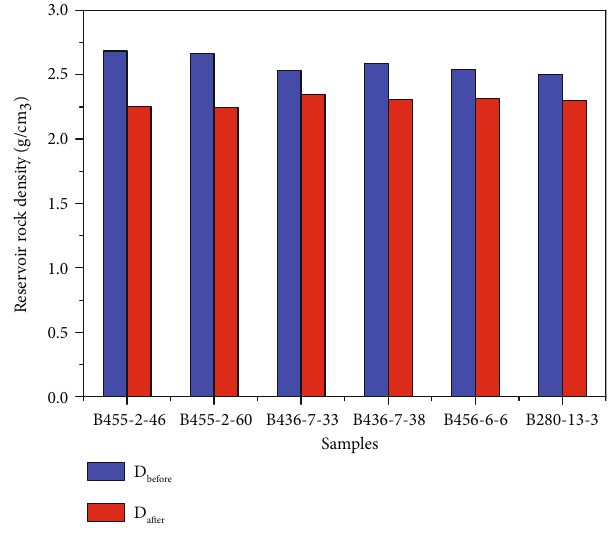
Figure 6: Variation of rock density before and after Soxhlet